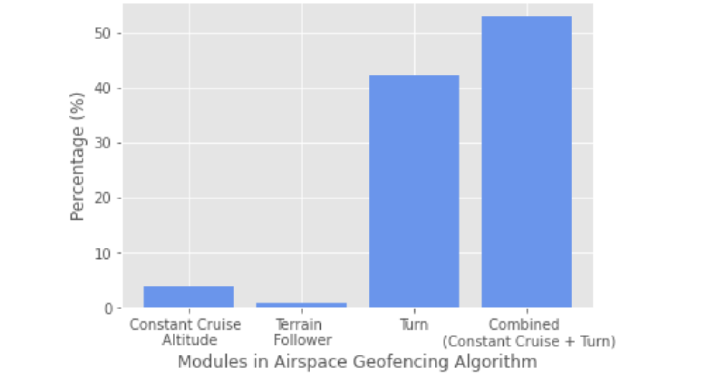
Figure 18. Percent frequency distribution of minimum-cost solutions over Monte Carlo simulations.